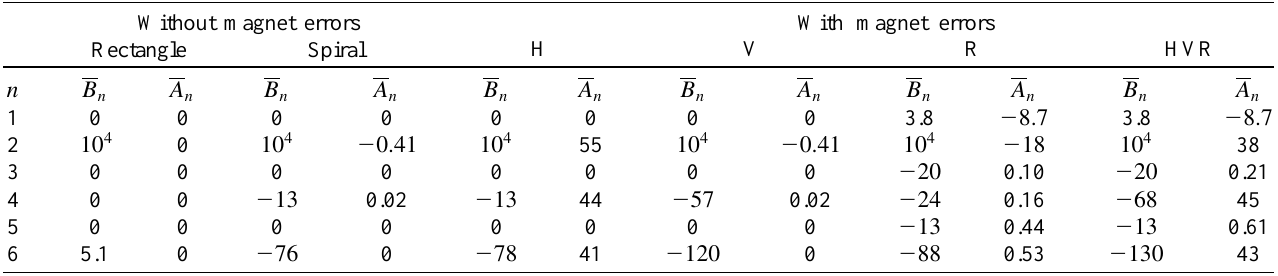
TABLE III. Results of MAG-PC calculations for UMER quadrupole magnets. The types of errors implemented are explained in the text and illustrated in Fig. 8. Without magnet errors